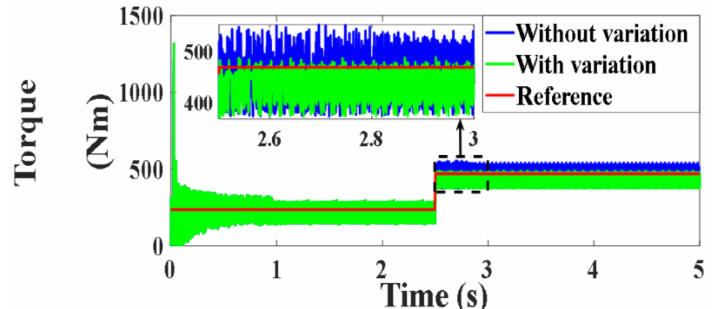
Figure 171. Developed torque under PVC (Nm).